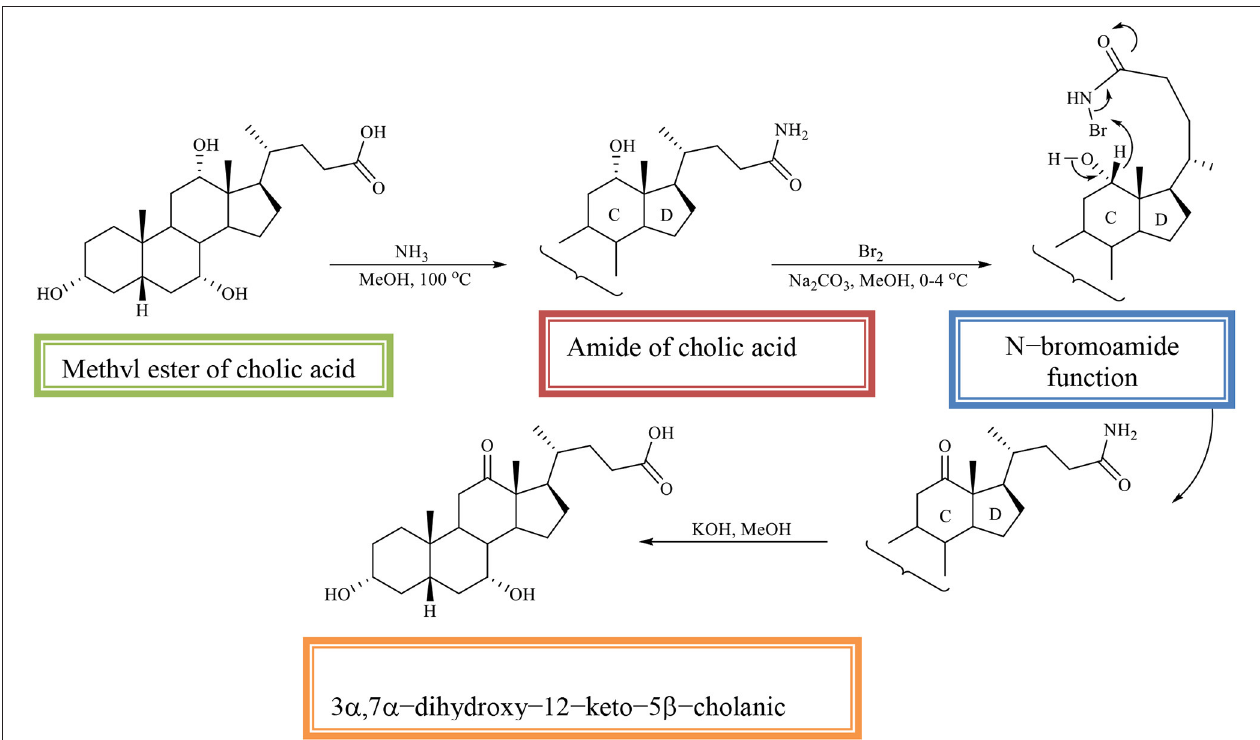
key role in transmission of BAs and bilirubin. The